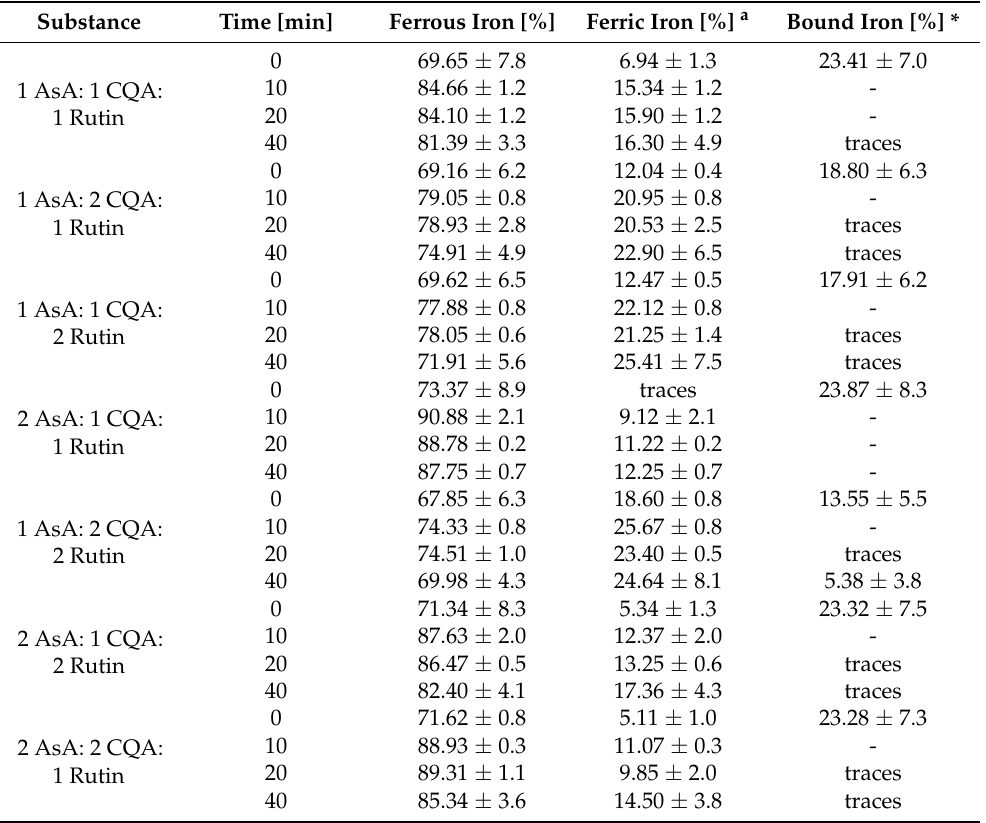
Table 3. Measured ionic iron species, ferric iron (Fe 3+ ) and ferrous iron (Fe 2+ ), and calculated bound iron after mixing with the ternary standard mixtures of ascorbic acid (AsA), 5-caffeoylquinic (CQA), and quercetin-3-rutinoside (Rutin), and cooking for 0, 10, 20, and 40 min with equimolar concentrations of ferrous and ferric iron in percent; traces ≤ 5 %. Substance Time [min] Ferrous Iron [%] Ferric Iron [%]